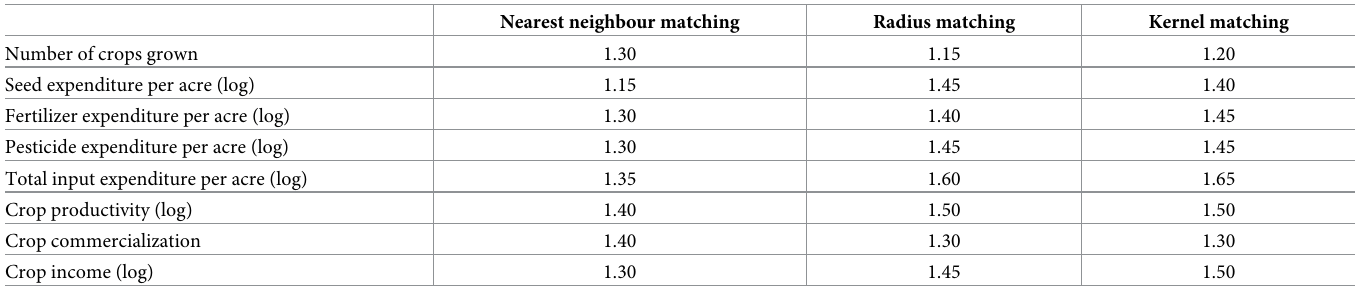
Table 6. Critical level of hidden bias ( Γ